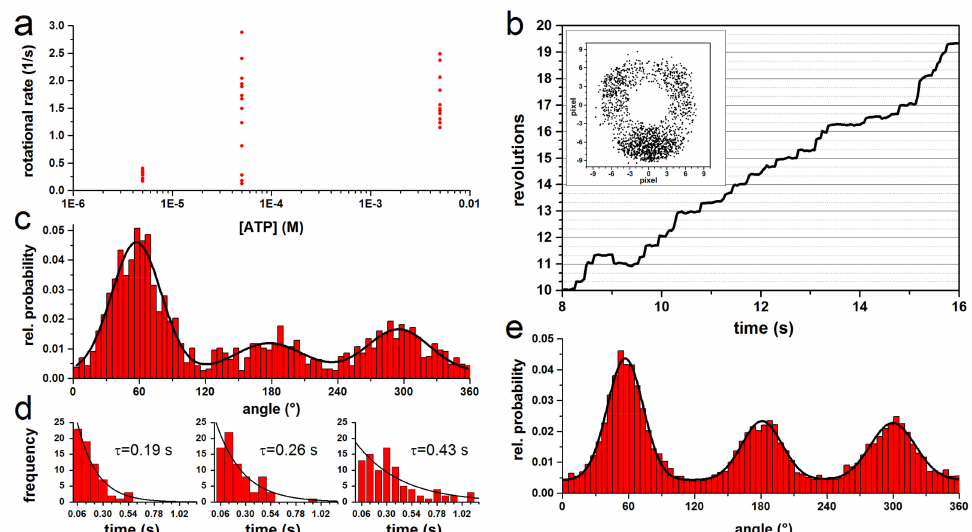
Figure 3. Properties of rotating actin filament-EcF O F 1 complexes during ATP hydrolysis. ( a ) Rotational rate versus ATP. For short actin filaments ( ≤ 1 µ m), the rotational rate is independent of the ATP concentration and the filament length. ( b ) Trajectory of a typical rotating complex at 100 µ M ATP in steps of 120 ◦ . The inset shows the endpoints of the 0.8 µ m actin filament. ( c ) Normalized histogram of the angular probability distribution of the complex in b , where the three peaks, separated by 120 ◦ , were fitted with a Gaussian. ( d ) Dwell time histograms of each peak in c fitted with monoexponential decay. The dwell times ( τ ) are given for each histogram. ( e ) Combined normalized histogram of the angular distribution of rotating actin filament from 13 single molecules at 50–5000 µ M ATP with 513 to 2174 frames per molecule. Each dataset was fitted with three Gaussians to determine the area of each peak. The datasets were aligned by positioning the largest peak at 60 ◦